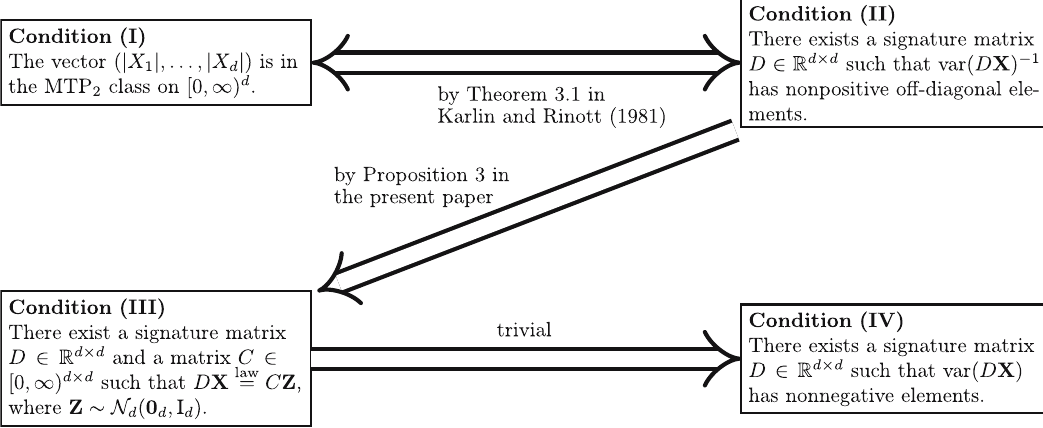
Figure 1: Implications between Conditions ( I ) – ( IV ) for a nonsingular centered Gaussian random vector X , with